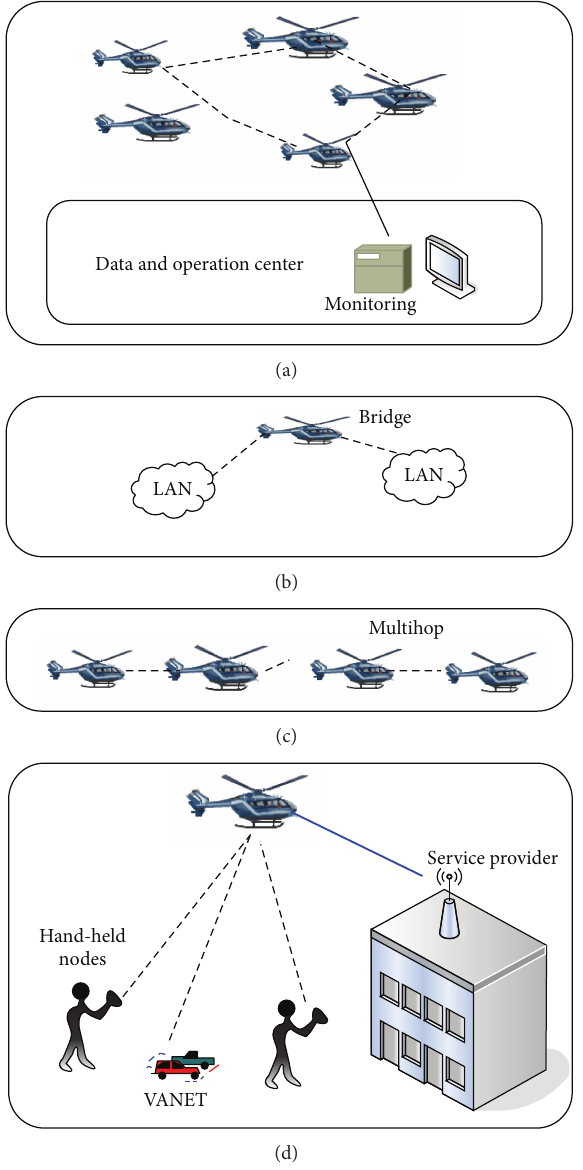
Figure 1: Helicopter network scenarios. (a) LAN and WAN. (b) Helicopter as bridge. (c) Extending network coverage range through multihops. (d) Providing Internet/network access for some users in specific